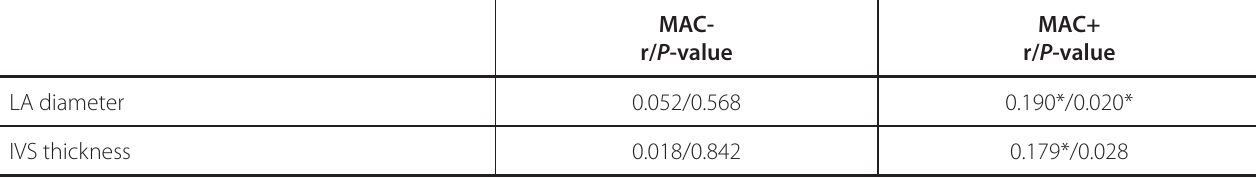
Table 3. Parameters correlated with CONUT score in MAC- and MAC+ patients.